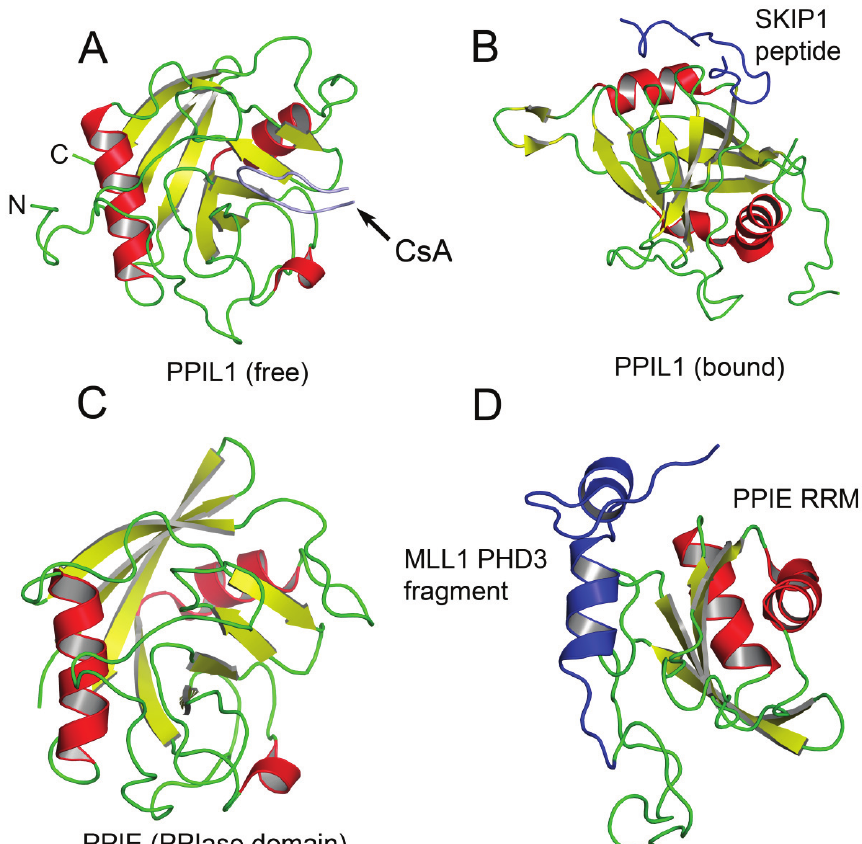
Figure 2. Structures of PPIL1 and PPIE free and complexed to spliceosomal proteins. In ( A ), the crystal structure of the free PPIase domain of PPIL1 is shown. The protein has a typical cyPA-like fold; In ( B ) the solution NMR structure of PPIL1 PPIase domain bound to the SKIP1 peptide is depicted. The SKIP1 peptide forms a hook like structure (in blue) and binds the PPIase domain at an allosteric site far removed from the active site; In ( C ), the crystal structure of the PPIase domain of PPIE is shown; In ( D ), the solution NMR structure of the MLL1-PHD3-PPIE-RRM complex is shown. The PHD3 fragment forms a helix that packs against the PPIE